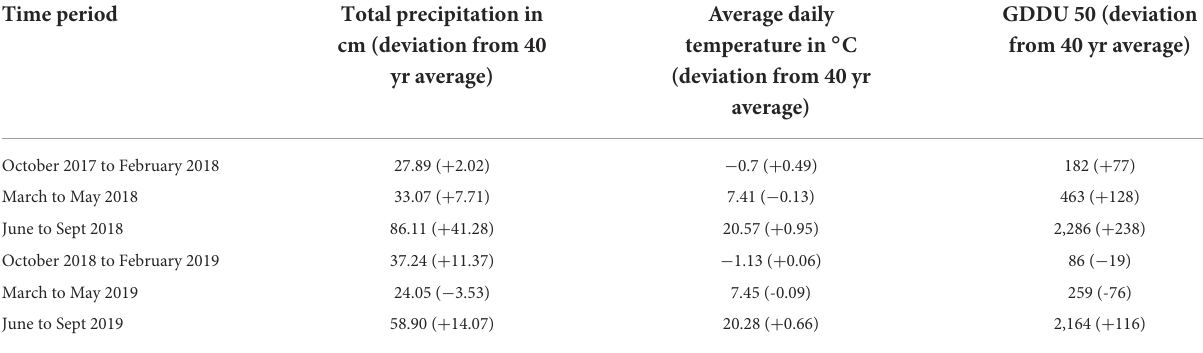
TABLE 2 Weather data collected at UW-Madison Arboretum Weather Station, 2018 and 2019. Time